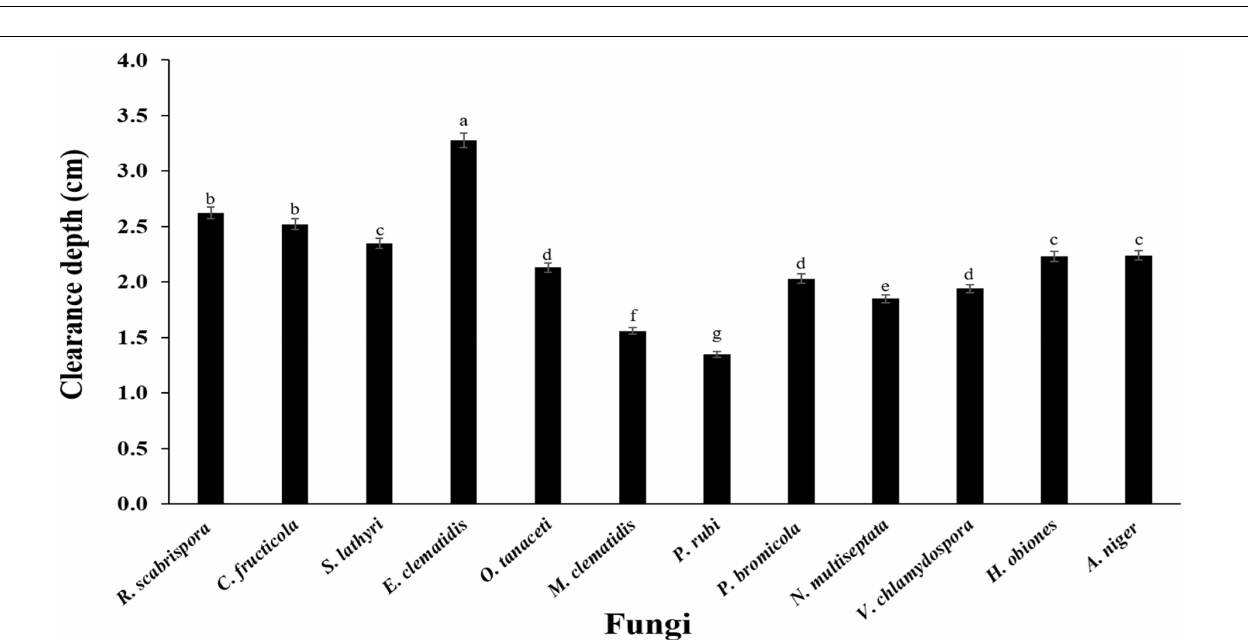
FIGURE 1 | Colony diameter of active fungi on solid medium plates after 2-week inoculation. Sign ∗∗∗ above the points indicates a significant difference ( p < 0.001) (ANOVA, followed by Dunnett’s test).